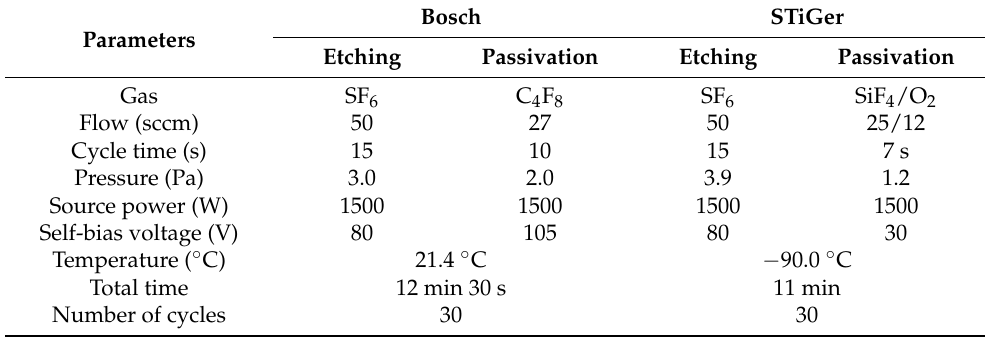
Table 1. Experimental conditions for both Bosch and STiGer processes, Alcatel 601E ICP reactor.